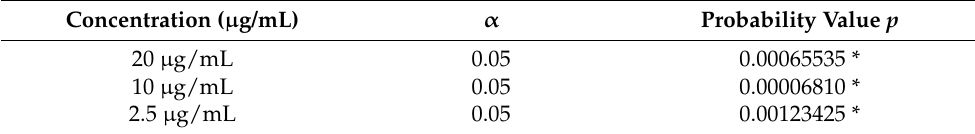
Table A2. p value of each evaluated dose.